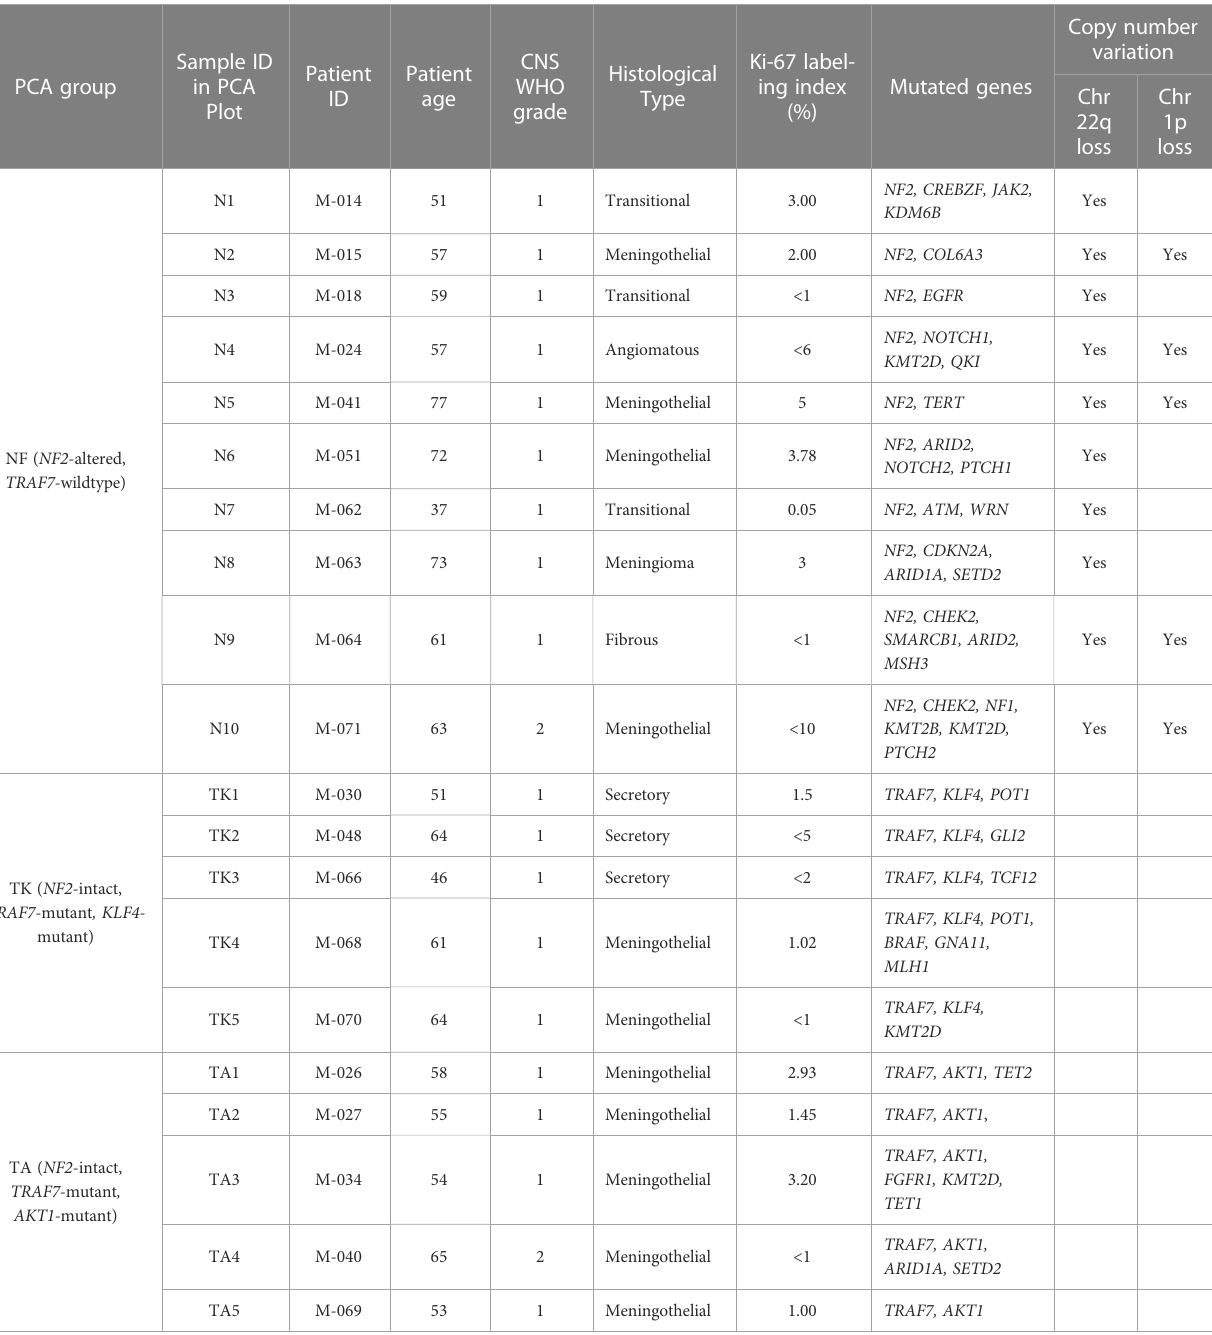
TABLE 1 Clinical features of patients, their meningiomas and identi fi ed mutations.